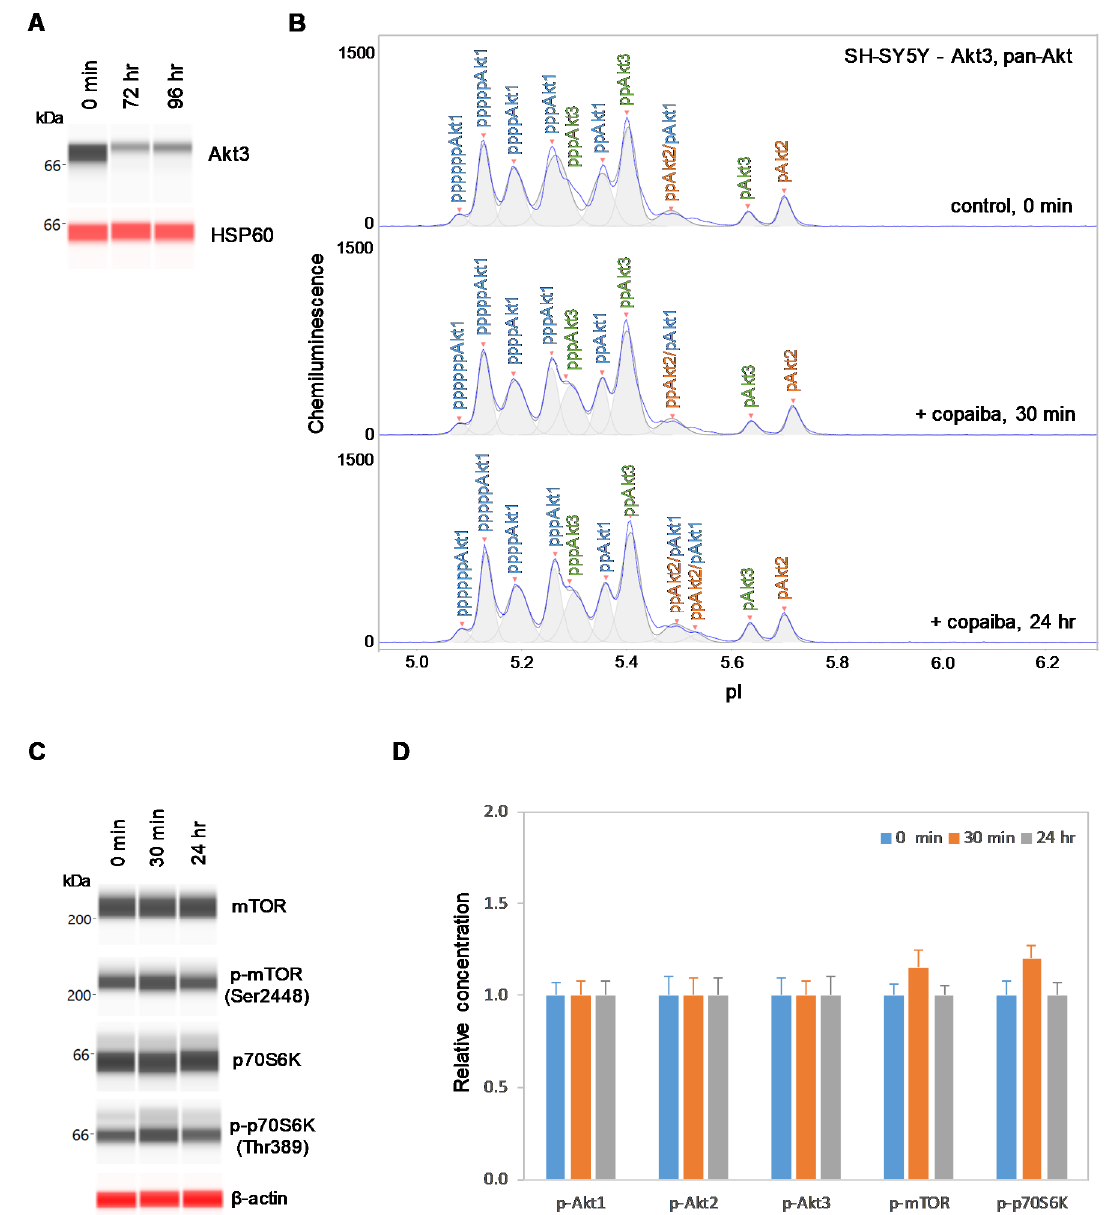
Figure 7. Suppression of Akt3 expression in SH-SY5Y cells reduces the positive regulation of the pI3K / Akt / mTOR signaling pathway by copaiba essential oil. ( A ) Expression levels of Akt3 in SH-SY5Y cells before (0 min) and after (24 h and 48 h) transfection with Akt3 siRNA. HSP60 served as the loading control. ( B ) cIEF electropherograms of pan-Akt in SH-SY5Y cells transfected with Akt3 siRNA for 24 h as a function of time after treatment with copaiba essential oil. Peaks associated with Akt isoforms are labeled and color-coded: Akt1 (blue), Akt2 (orange), and Akt3 (green). ( C ) Expression levels of the mTOR and p70S6K phosphoisoforms as a function of time after treatment with copaiba essential oil. β -Actin served as the loading control. ( D ) Relative concentrations of Akt1, Akt2, Akt3, mTOR, and p70S6K phosphoisoforms as a function of time after treatment with copaiba essential oil. The relative concentration describes the fold change in the expression level of a protein phosphoisoform after treatment compared to that under the control condition. The error bars indicate the standard deviations of six repeated measurements per experimental condition. SH-SY5Y cells were treated with 100 ng / mL copaiba essential